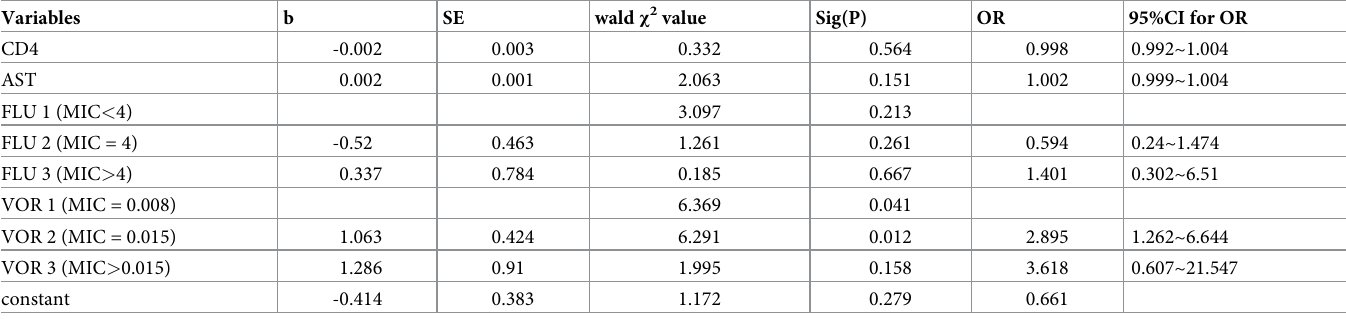
Table 4. Binary logistic regression analysis for the influencing factors of the clearance of Talaromyces marneffei in blood culture after antifungal therapy among AIDS patients with talaromycosis.